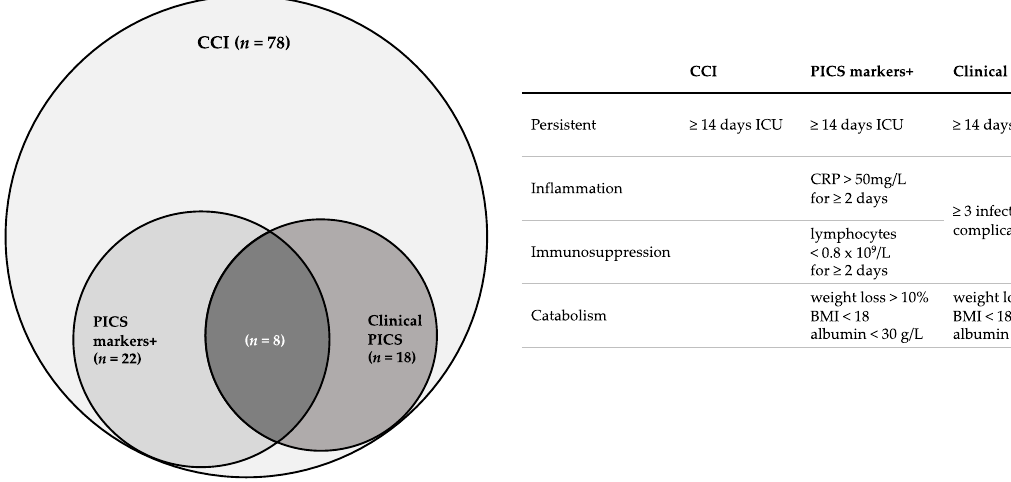
Figure 1. Overview of definitions used in this study and number of patients who fulfilled criteria according to these definitions. CCI = chronic critical illness, PICS = persistent inflammation, immunosuppression and catabolism syndrome, ICU = intensive care unit, BMI = Body Mass Index.